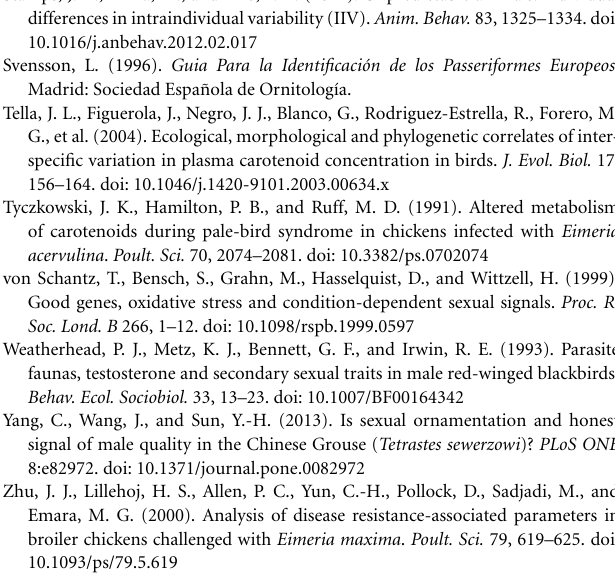
Citation: Figuerola J, López G and Soriguer R (2014) Plasma carotenoid levels in passerines are related to infection by (some) parasites. Front. Ecol. Evol. 2 :47.